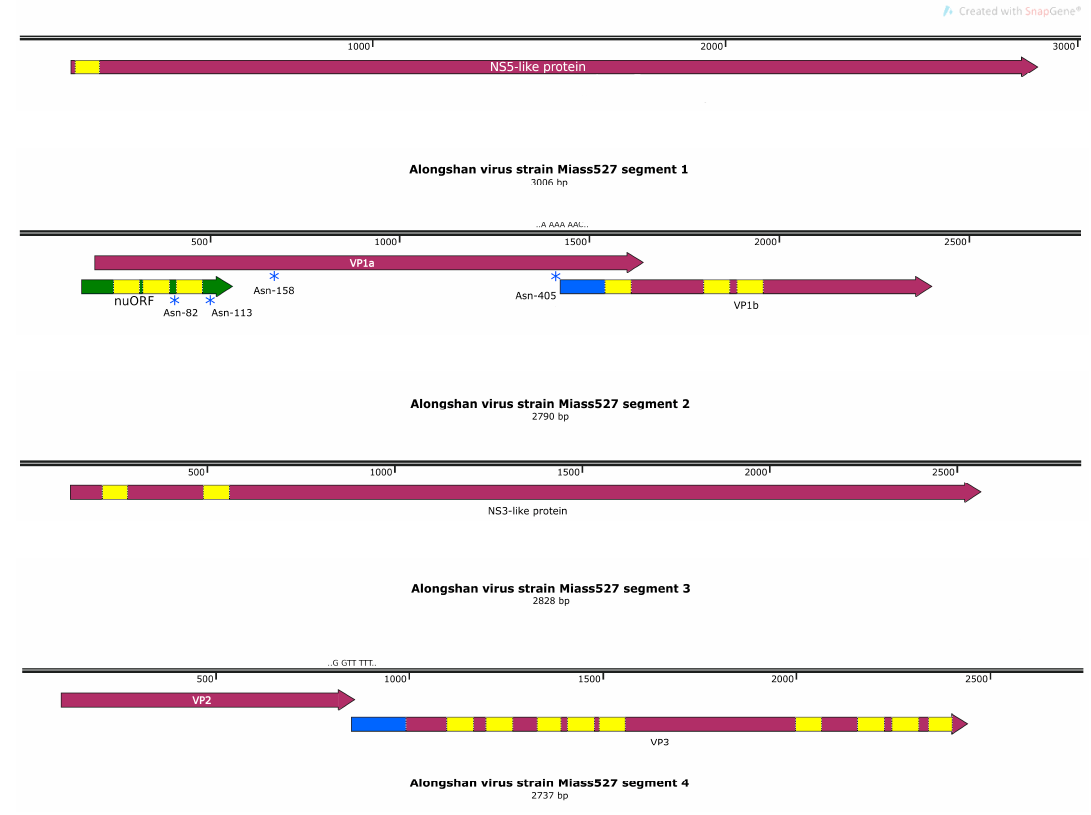
Figure 5. Genome of the Alongshan virus strain Miass527. Transmembrane regions are shown in yellow, the part of the VP1b protein derived from the proposed ribosomal frameshift is shown in blue, and the proposed novel protein in segment 2 is in green. Blue stars mark the putative N-glycosylation